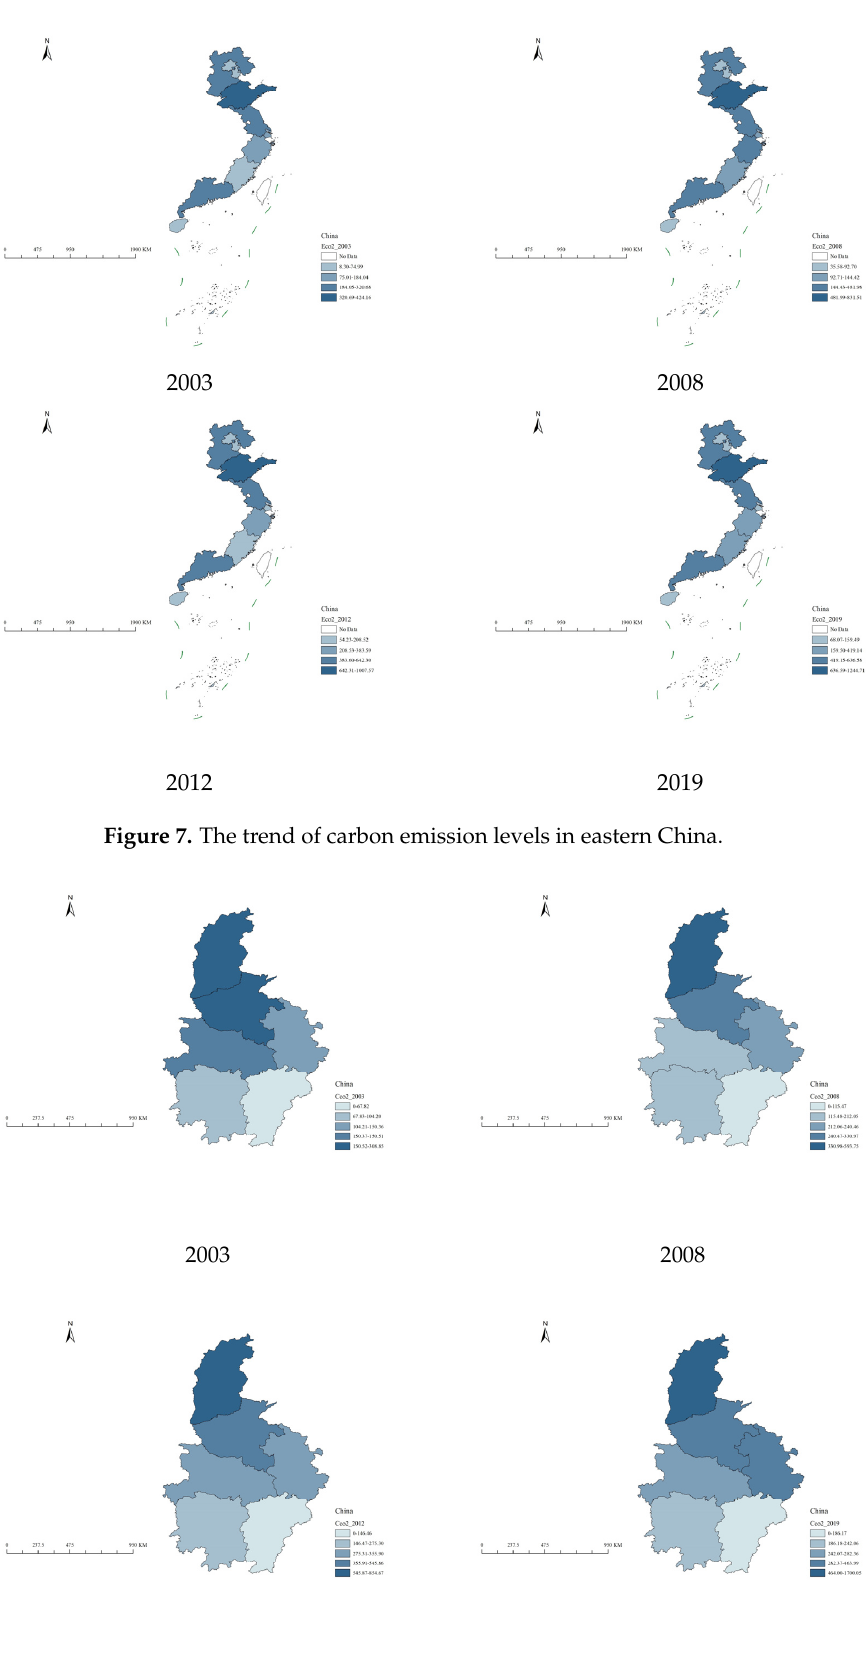
2019 Figure 6. The level of carbon emissions in China. Eastern China has always maintained the rising trend of carbon emission levels, keeping the second position in Figure 7. Obviously, as an economically developed region,